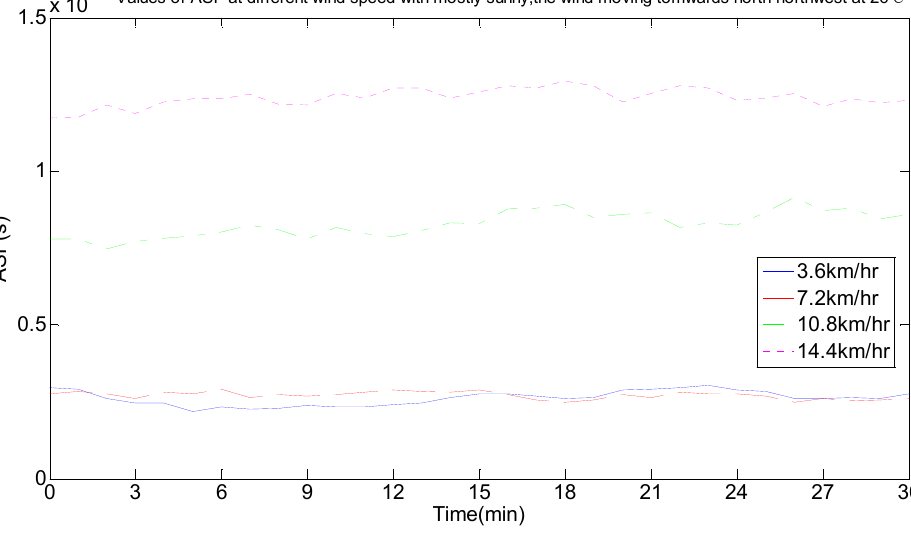
Figure 13. ASF values changing with different wind speed conditions.